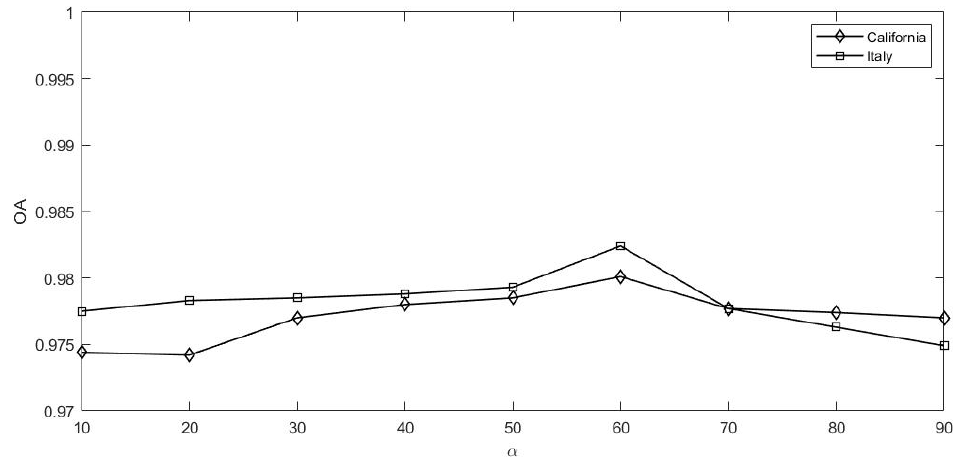
α on the performance of our method. Figure 3. The impact of